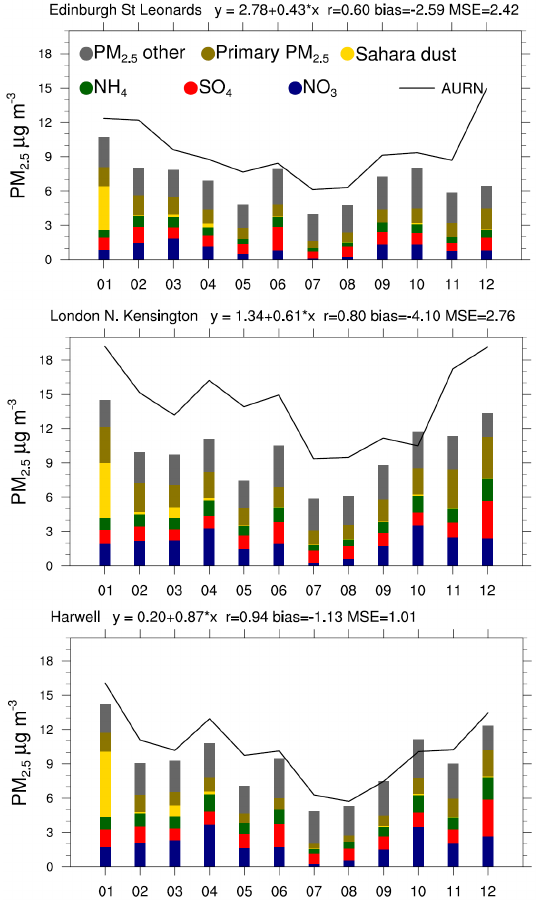
Figure 2. Gridded UK population density based on the UK cen- sus at the 5km × 5km grid spatial resolution. Units are popula- tionkm − 2 .